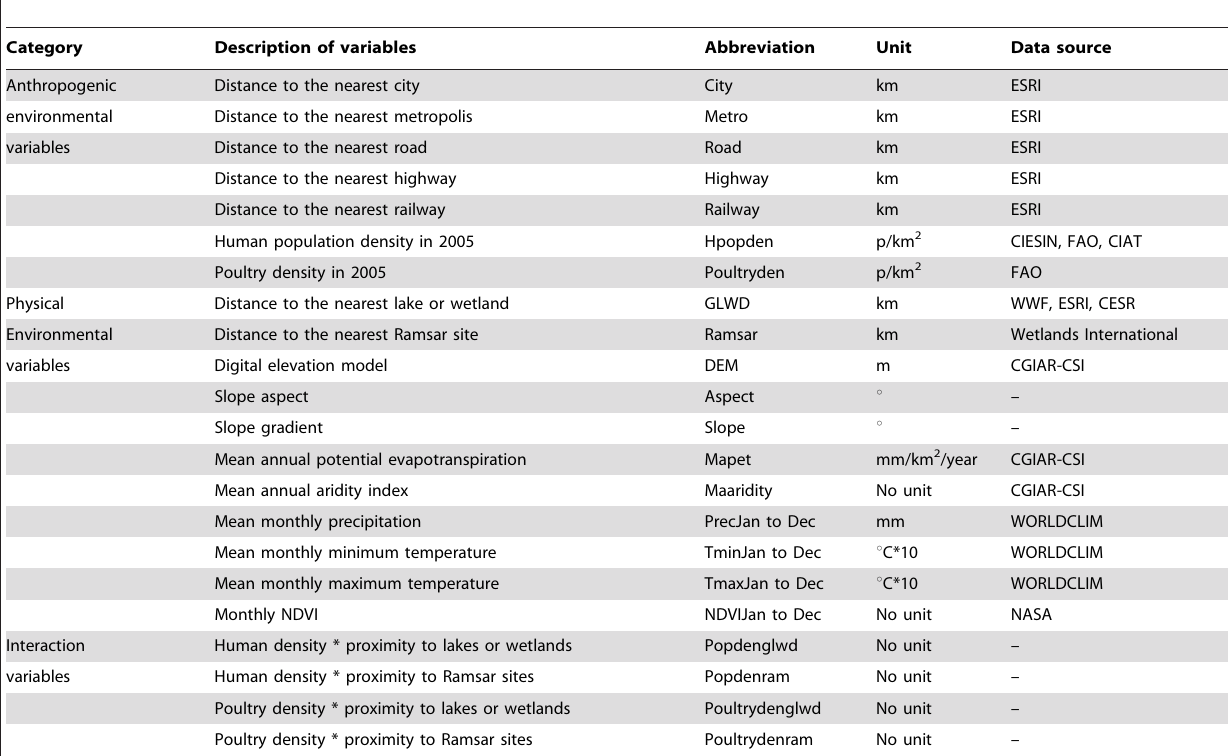
Table 1. Summary of the anthropogenic, physical environmental variables and interaction variables used in the